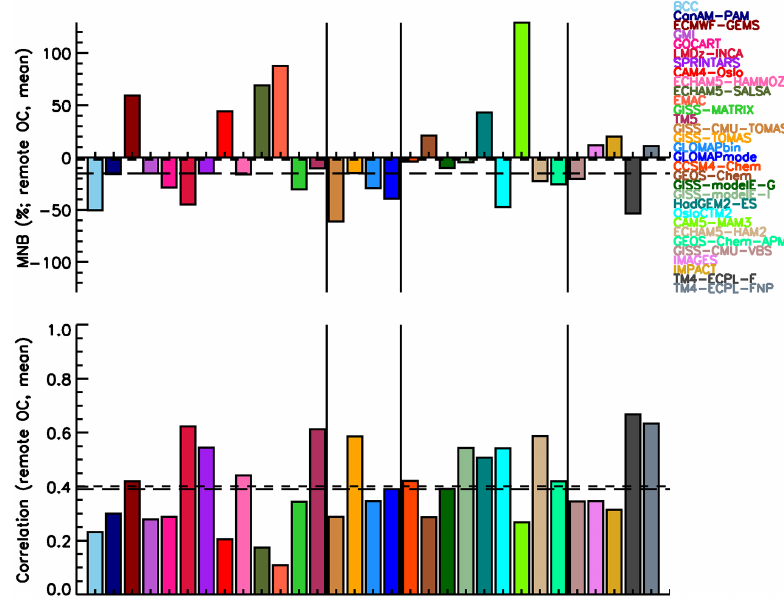
Figure 12. Same as Fig. 10, for remote OC measurements.